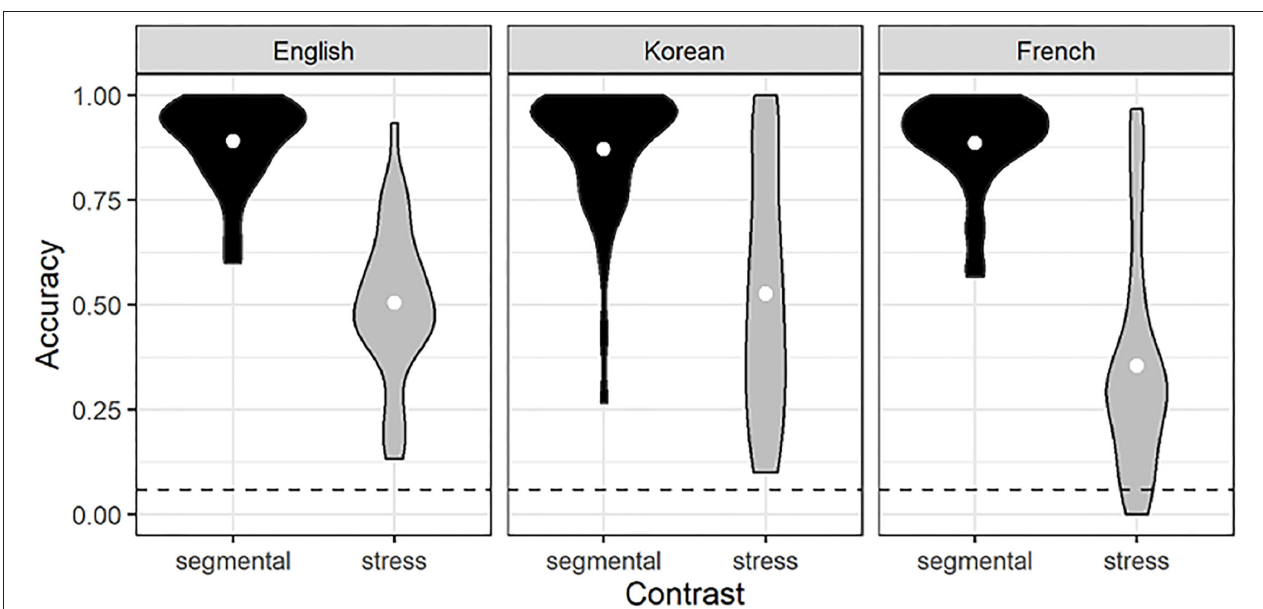
FIGURE 3 | Listeners’ accuracy on the sequence-recall task. The length of the violins represents the range of values; the width of the violins at a given y value represents the point density at that value; the white dots represent the mean; the dashed line represents chance-level performance (1 hit/16 possible sequence orders =